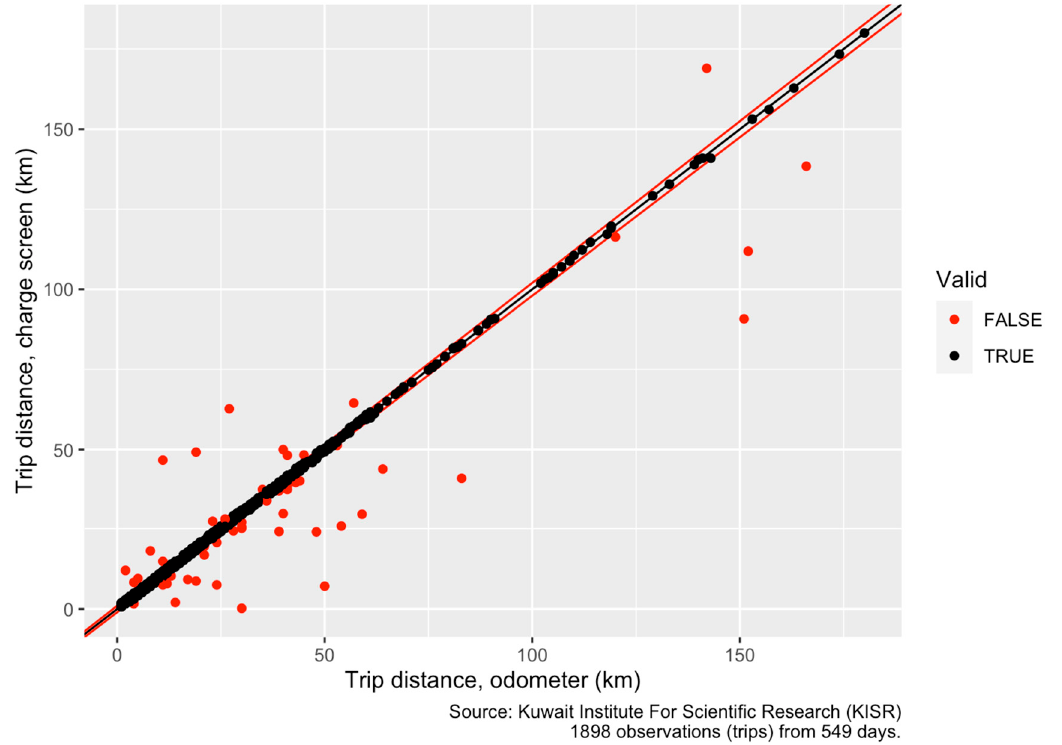
Figure 2. Scatter plot of recorded trip distances obtained through odometer and vehicle status screen. Black line indicates both measures equal, red lines indicate allowance for rounding and tolerance (odometer distance ± 1% ± 1 km). Points lying outside of tolerance are shown in red.